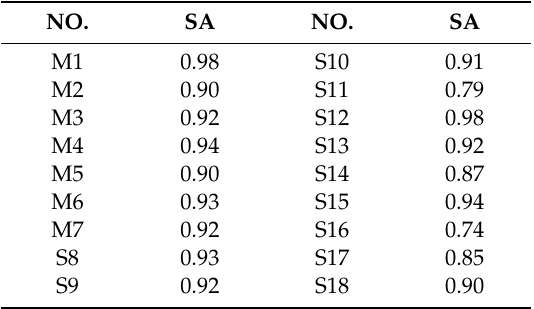
Table 3. Similarity analysis of 18 Batches of Farfarae Flos (FF)